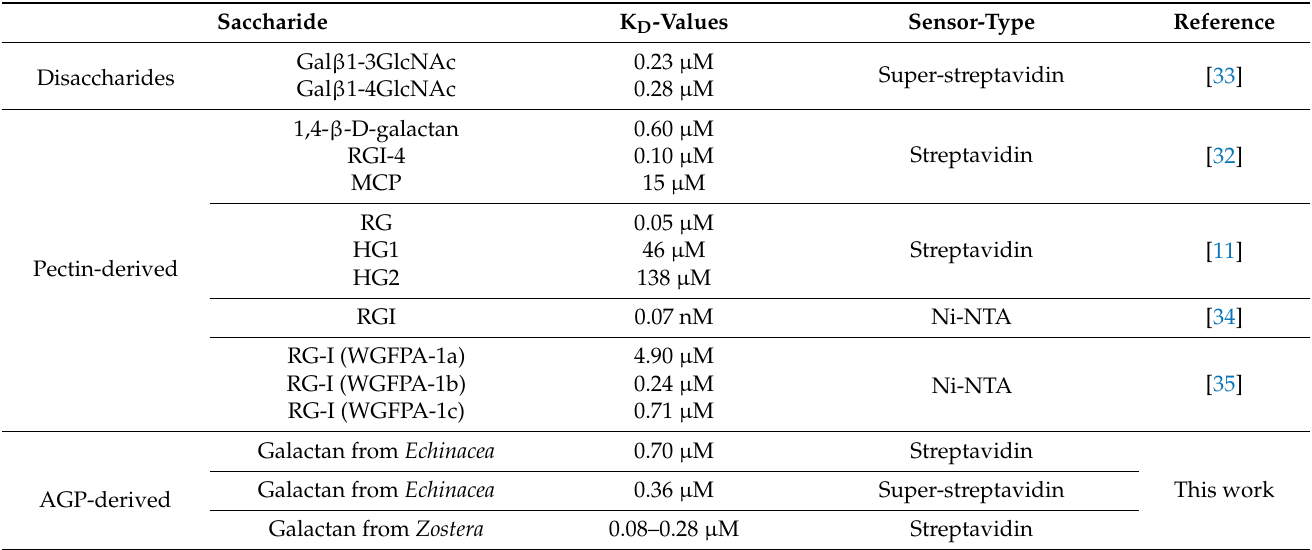
Table 5. Overview on K D -values for binding of different saccharides to Gal-3 determined by BLI.